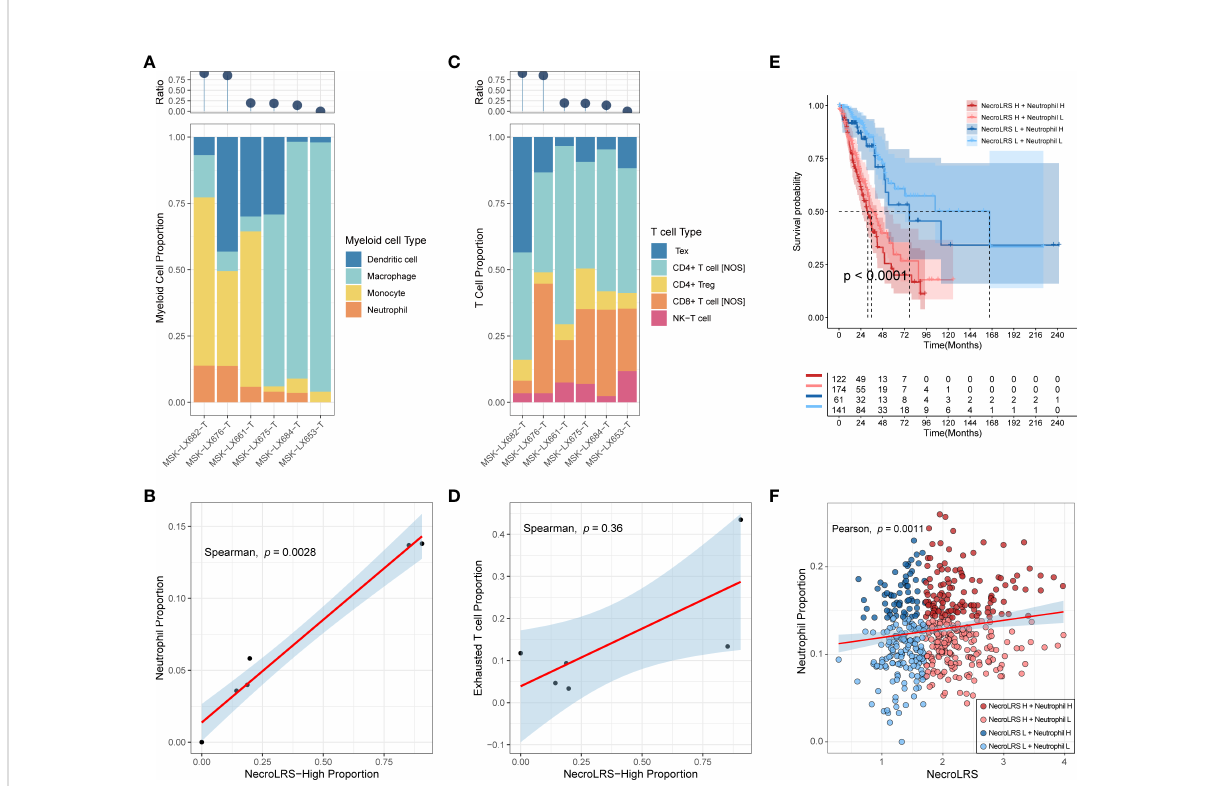
FIGURE 9 Immune abundance analysis of NecroLRS-related cell subgroups. The proportion of myeloid (A) and T (C) cell subtypes were visualized using stacked-bar diagrams and sorted according to the proportion of NecroLRS-High cells in malignant cells. (B) Correlation between the proportion of NecroLRS-High cells among malignant cells and the proportion of neutrophils among the myeloid cells. (D) Correlation between the proportion of NecroLRS-High cells among malignant cells and the proportion of exhausted T cells. (E) Survival analysis across different permutations of NecroLRS- and neutrophil-related patient groups in bulk-seq (TCGA whole cohort). (F) Correlation between NecroLRS and the proportion of neutrophils based on ImmuneCellAI algorithm in bulk-seq (TCGA whole